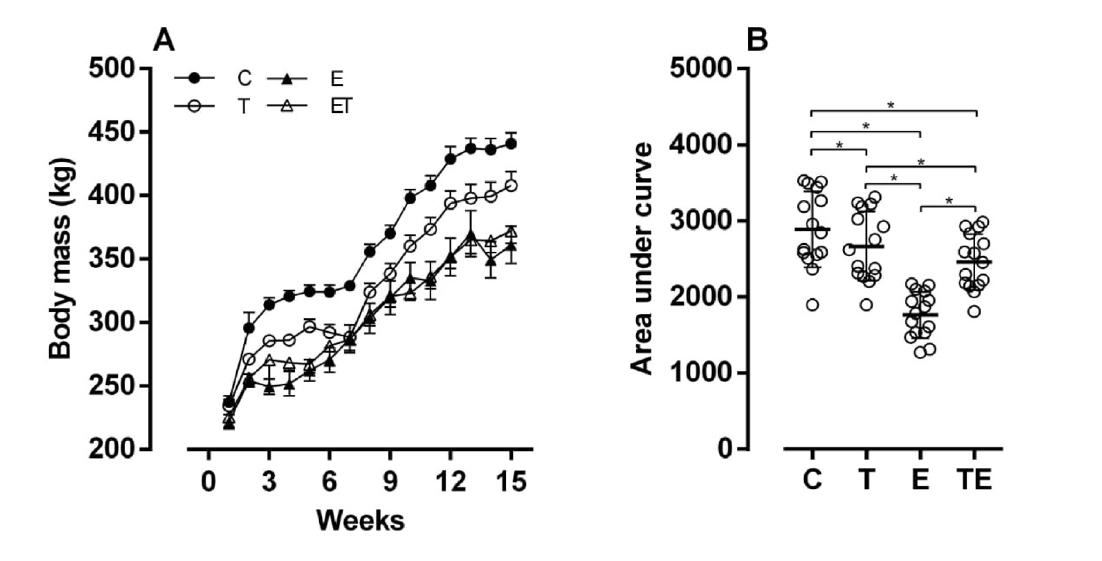
Figure 1 - Body mass development (Panel A) and area under curve of body mass development (Panel B) by control (C), trained (T), exposed to cigarette smoke (E) and trained and exposed to cigarette smoke (TE) groups. Values expressed as means ± standard deviations. *p<